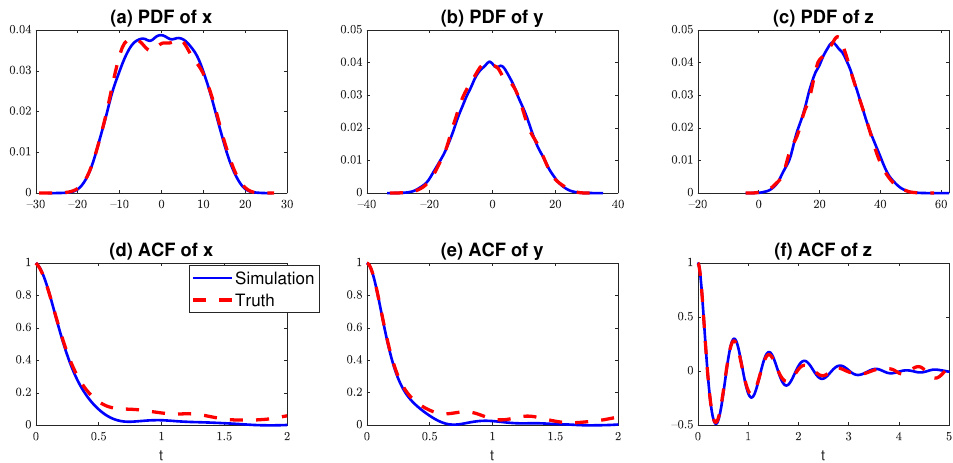
Figure 3. Comparison of the PDFs and ACFs of a long simulation from the noisy Lorenz 63 model with the true parameters (13) (dashed red curves) and that with the estimated parameters (solid blue curve). The last point in each of the trace plots is regarded as the estimated value of each